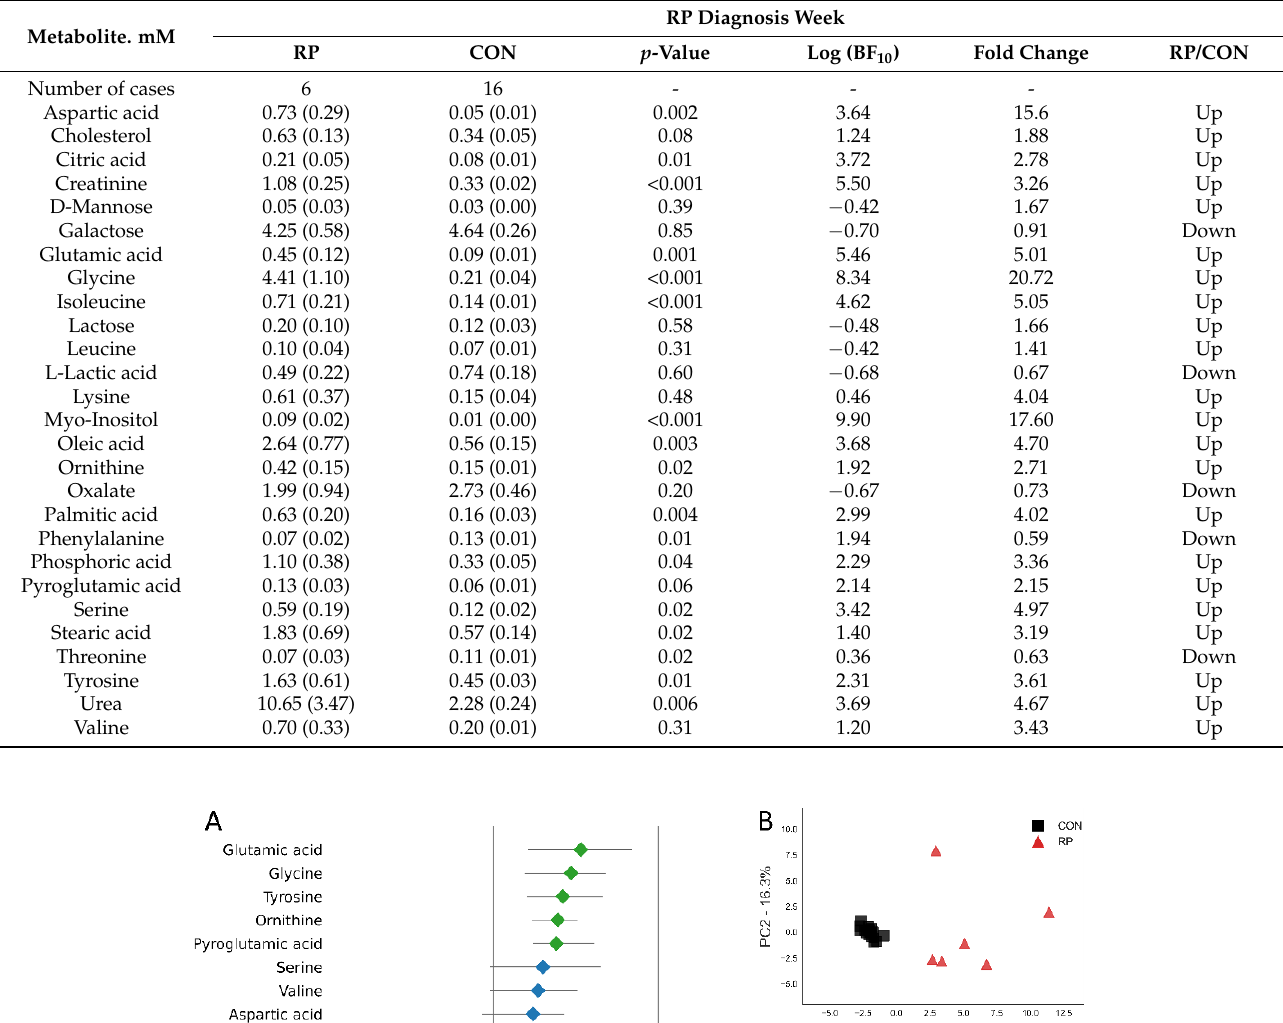
Table 3. Concentrations of altered serum metabolites [mean(SD)] in healthy controls (CON) and retained placenta (RP) cows at disease diagnosis week as determined by GC/MS.